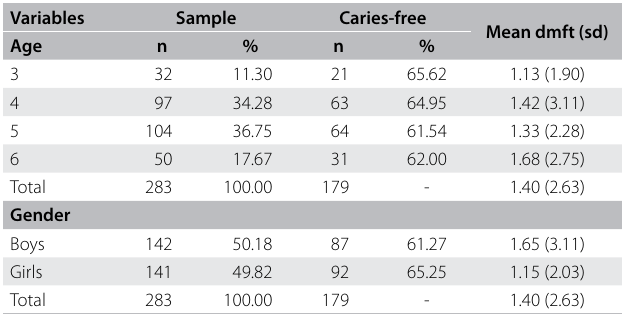
Table 1. Caries experience according to age and gender, Bauru, Brazil,